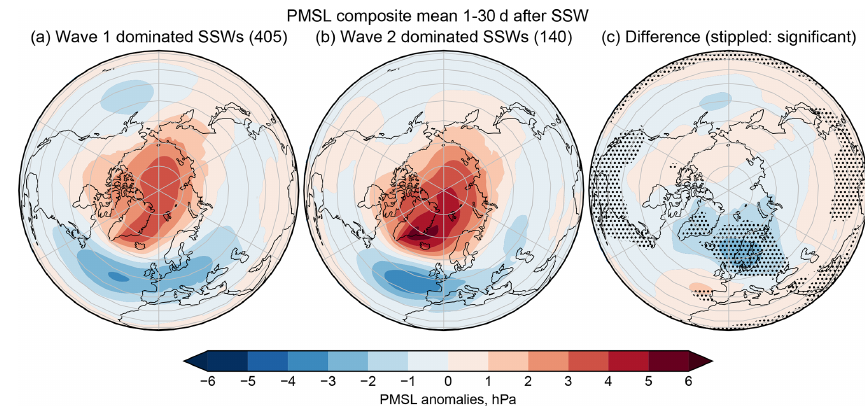
Figure 7. Surface response to wave-1- and wave-2-dominated SSWs. The left (a) and centre (b) panels show the composite mean PMSL anomalies 30d post-SSW for the two sets of SSW events. The right-hand panel (c) shows the difference (wave-1-dominated cases minus wave-2-dominated cases), with stippling indicating where the differences are statistically significant.